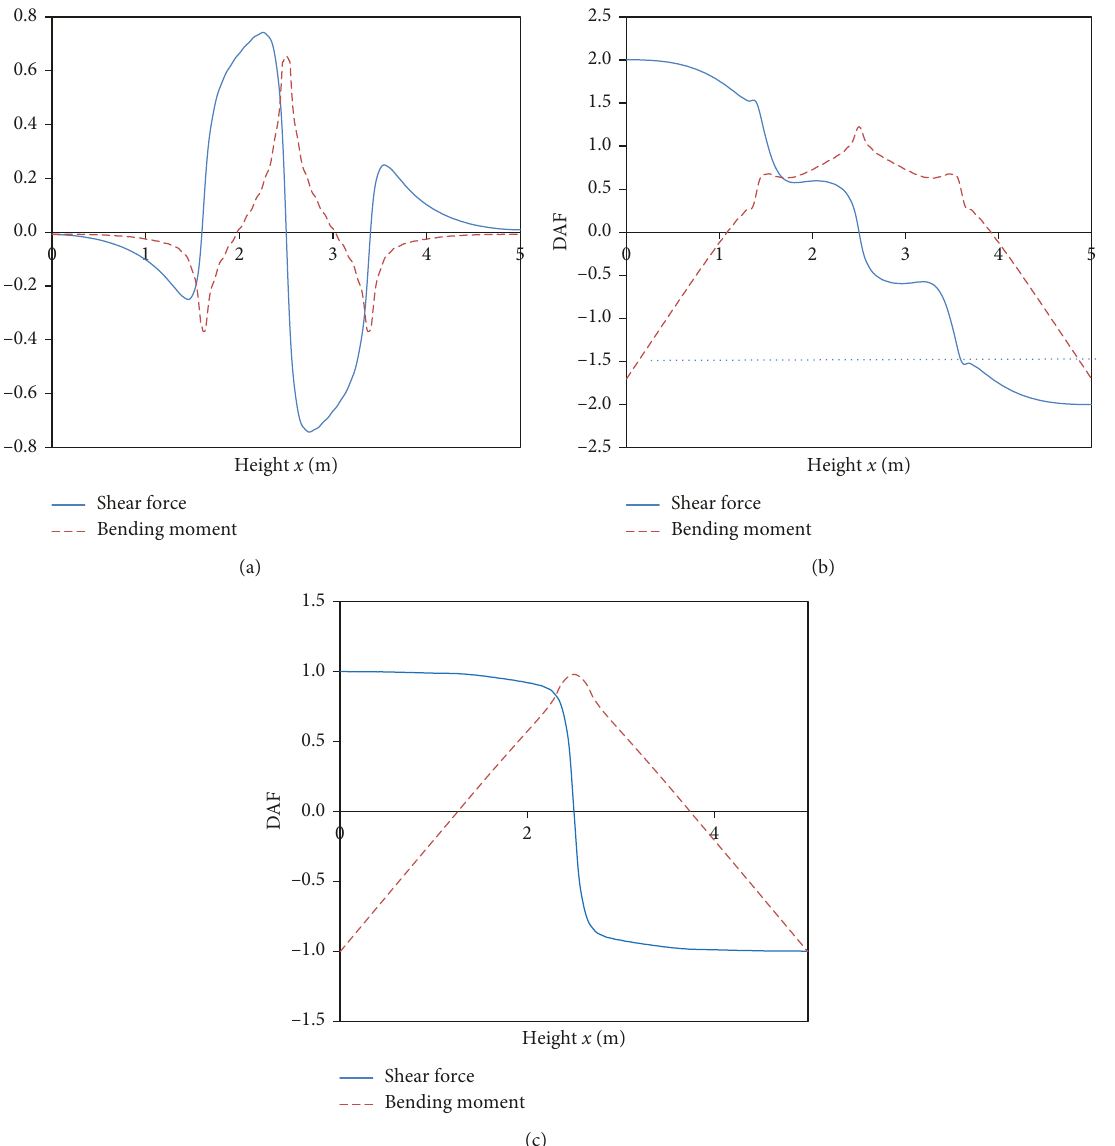
Figure 4: Distribution of DAF of internal forces of bridge columns at different timestamps under impact load. (a) Right triangle of t 0.5ms. (b) Right triangle of t d / T 1